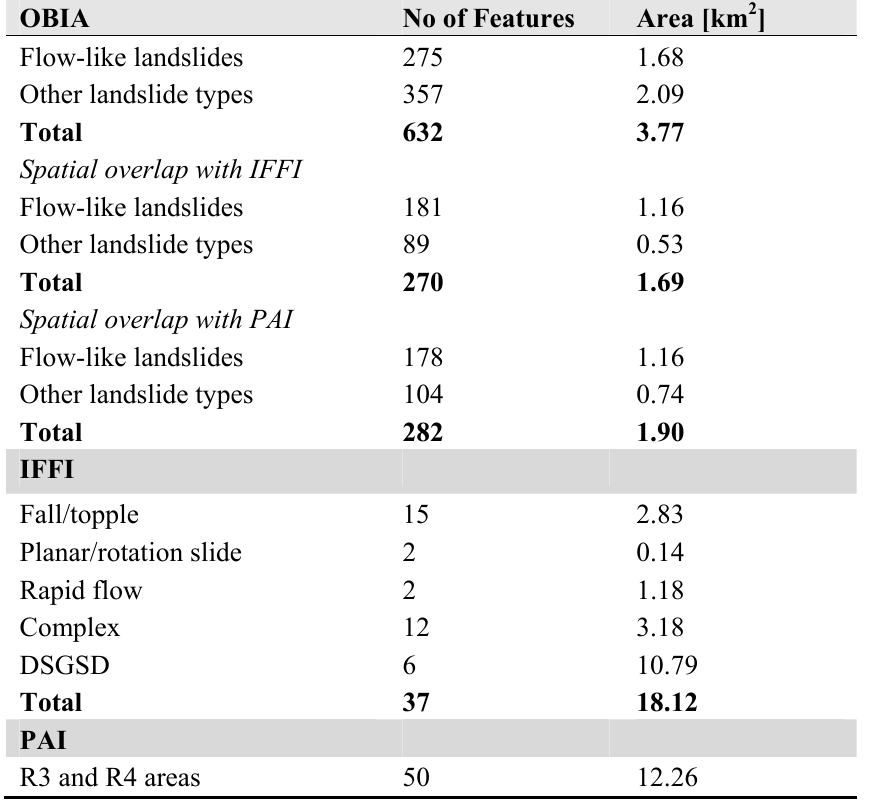
Table 1. Number of features and area of the landslides included in IFFI and PAI inventories compared to the results of the object-based image